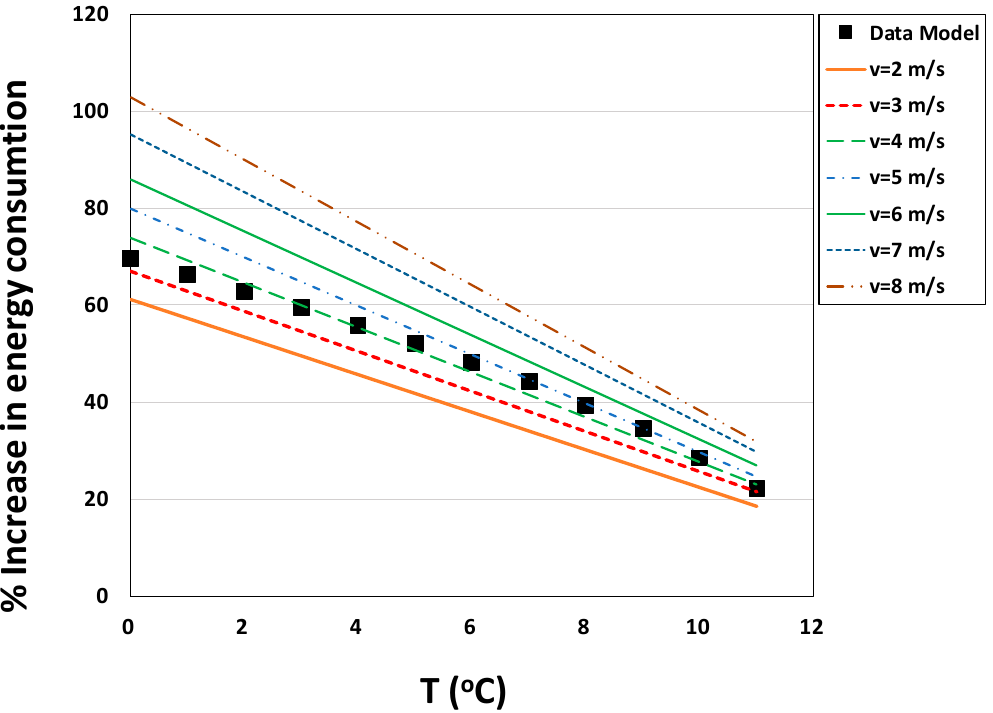
Figure 10. Energy increase requirement for operation with increased cycling for all pumps (additional feed pumps plus pumps used for transport of heated circulating water). Power requirements shown are based on cooling times calculated using various wind speeds from the tabulated model and from the heat transfer coefficient derived in the data-based model.